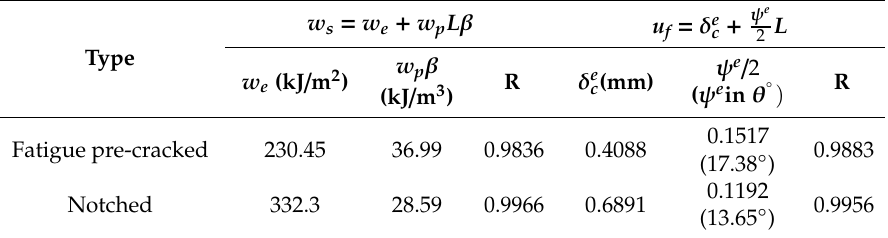
Figure6. Specificworkoffractureversusligamentlengthfornotchedandfatiguepre-crackedspecimens. Figure 6. Specific work of fracture versus ligament length for notched and fatigue pre-cracked Figure 5. Maximum stress versus ligament length for all DENT specimens. specimens. Table 1. Essential work of fracture experimental results.